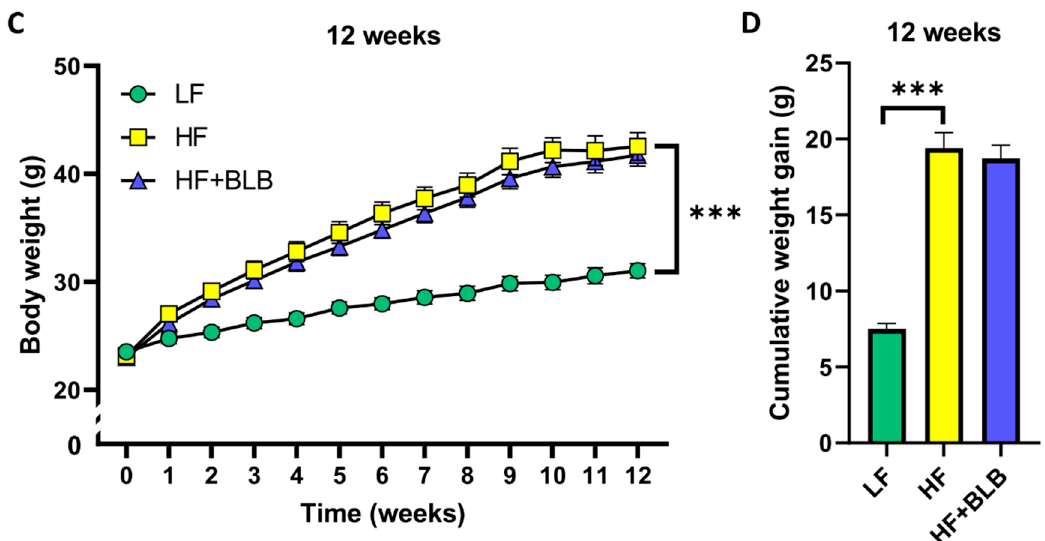
Figure 1. The body weight gain during the study. The mice received a low-fat diet (LF, 10% of energy from fat, circle), a high-fat diet (HF, 46% of energy from fat, square) or a bilberry-supplemented high-fat diet (HF+BLB, 20% air-dried bilberry powder, triangle) for six ( A , B ) or twelve ( C , D ) weeks. The weights were analyzed with repeated measures, such as a two-way (mixed model) ANOVA and a Bonferroni multiple comparisons test ( A , C ). The cumulative weight gain was analyzed with a one-way ANOVA and a Bonferroni multiple comparisons test ( B , D ). The statistically significant differences from the HF group are marked with *** p < 0.001. The results are expressed as grams; values represent mean ± SEM, n = 12 mice in each group.